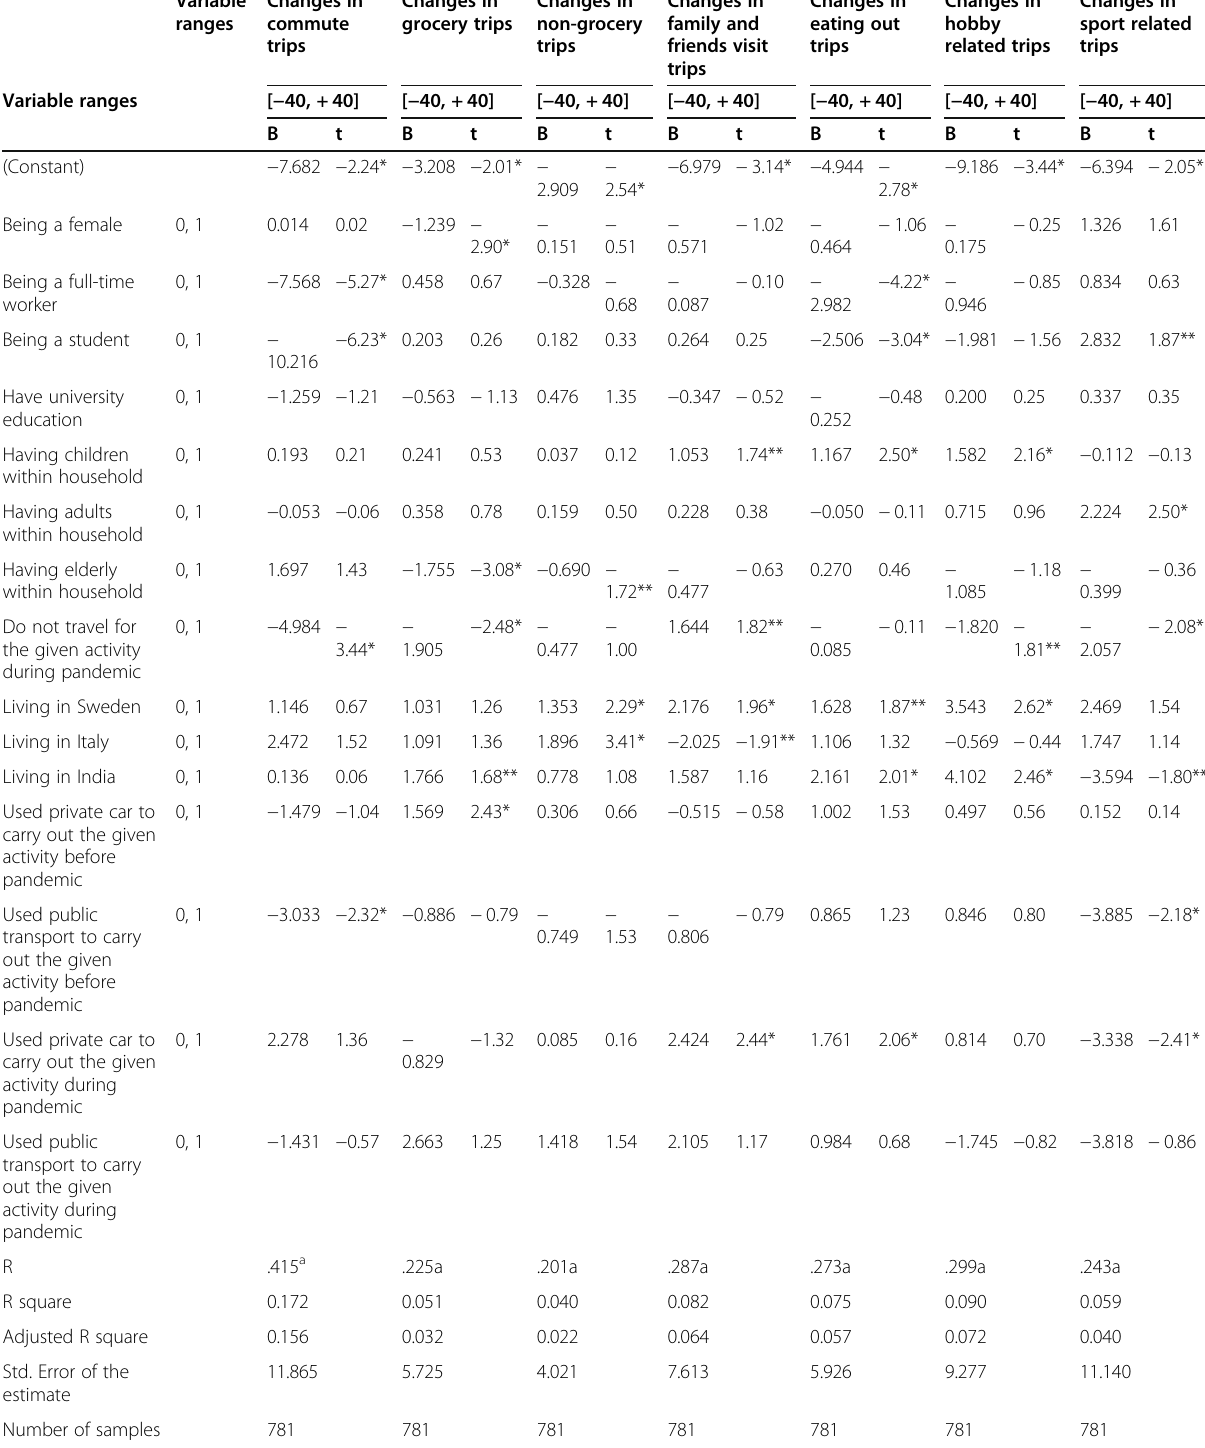
Table 2 Regression models for the decreased amount in monthly trips for different activities